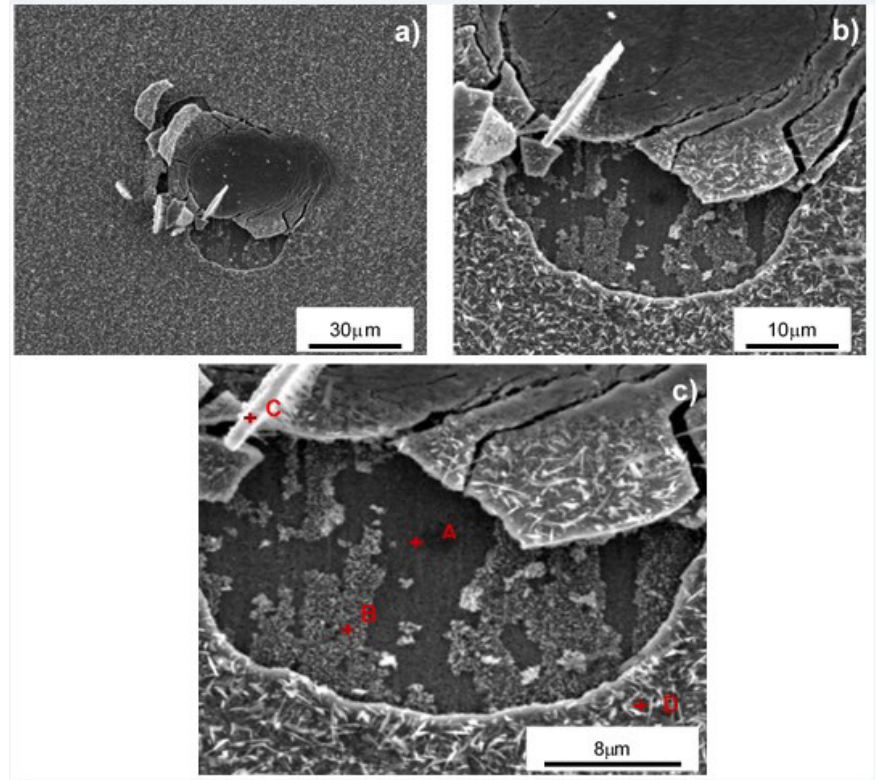
/steam/N atmosphere on maraging 300 2 2